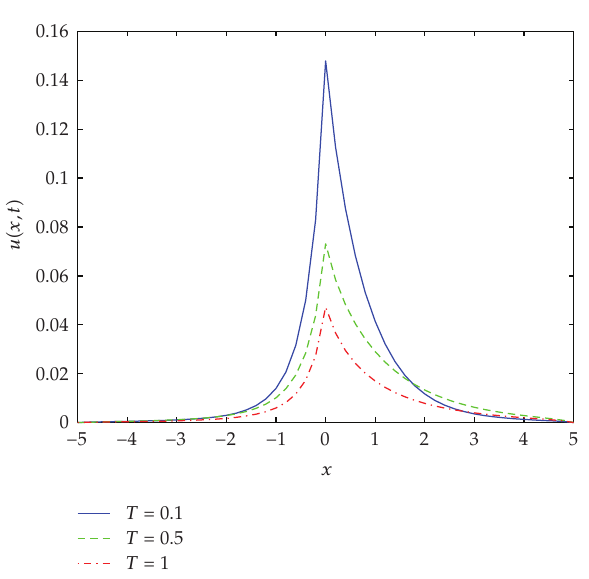
Figure 7: Numerical solutions for Example 5.3 with α (cid:7) 0 . 5 and μ (cid:7) 1 . 5 at di ff erent times T (cid:7) 0 . 1 , 0 . 5 , 1 . 0.